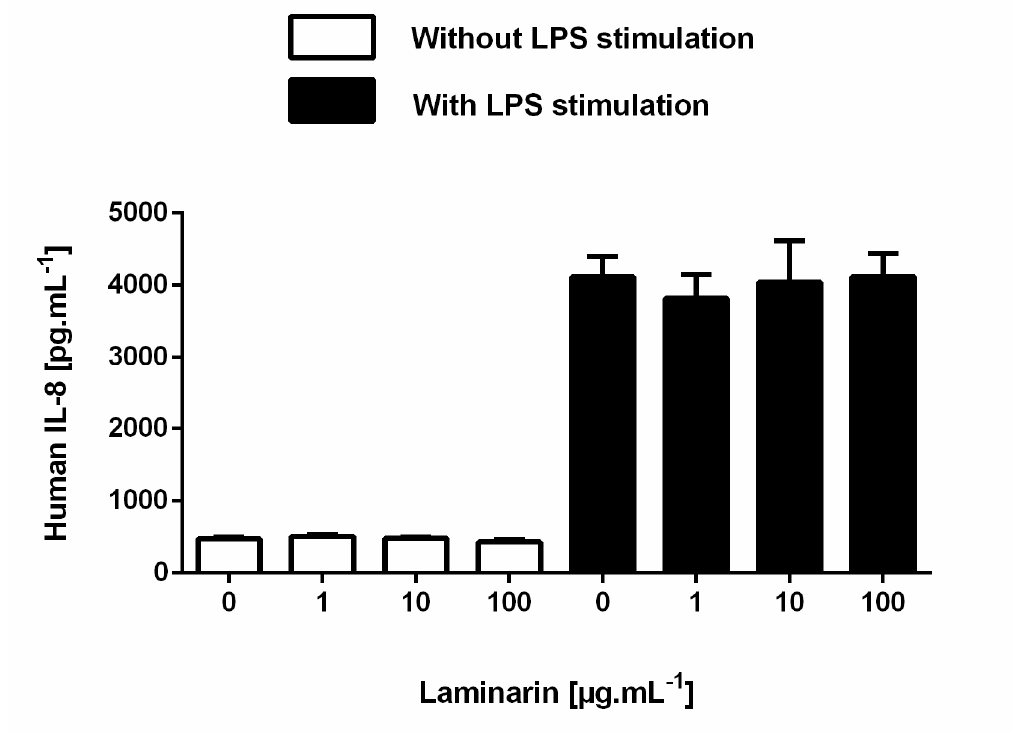
Figure A6. Quantitative analysis of IL-8 cytokine with an ELISA kit. HaCaT cells were stimulate with 1, 10 and 100 µg.mL − 1 laminarin for 48 h in absence or in presence of LPS at 10 µg.mL − 1 . An ELISA assay was performed to quantify the level of IL-8 cytokine secretion on the cell culture medium supernatant. Data are expressed as mean ± SD of two independent experiments.